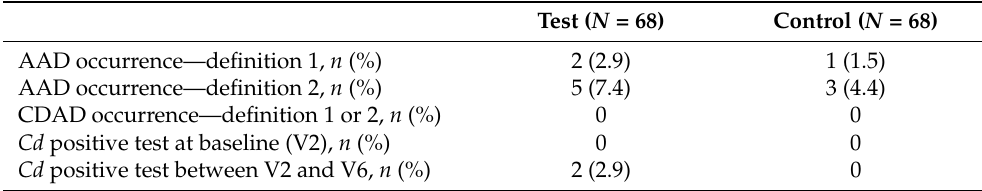
Table 2. Occurrence of AAD and CDAD. Occurrence of AAD and CDAD during the 28-day product consumption period. AAD Definitions: Three or more BSS 5–7 stools per day for at least three